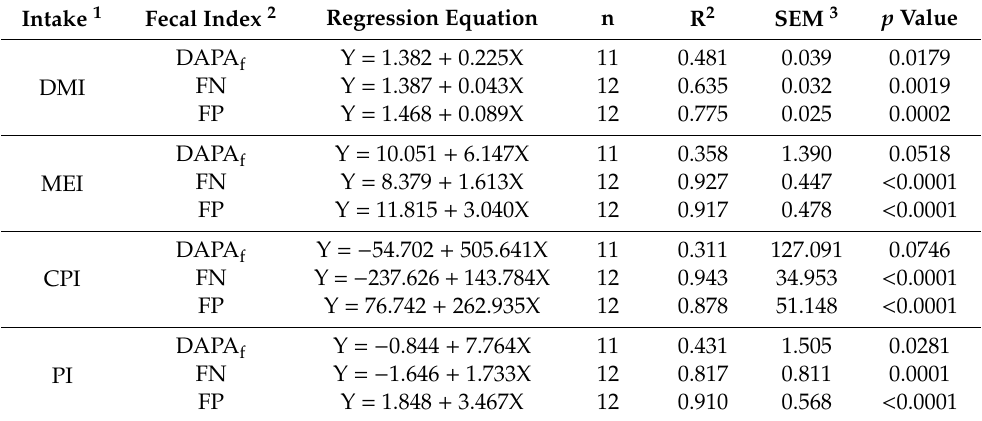
Table 5. Relation between nutrient intake (Y, g day − 1 ) and fecal indices (X, mg g − 1 OM or %) in grazing